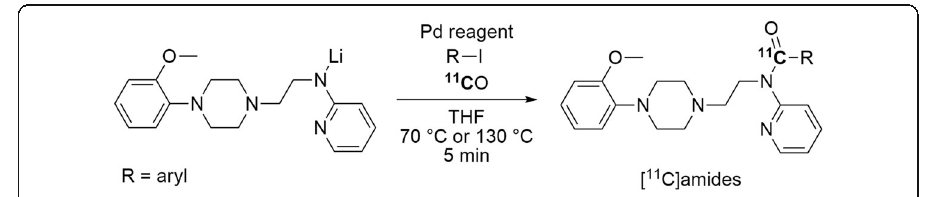
Fig. 9 Synthesis of [ 11 C]amides from lithiated amines through Pd-mediated 11